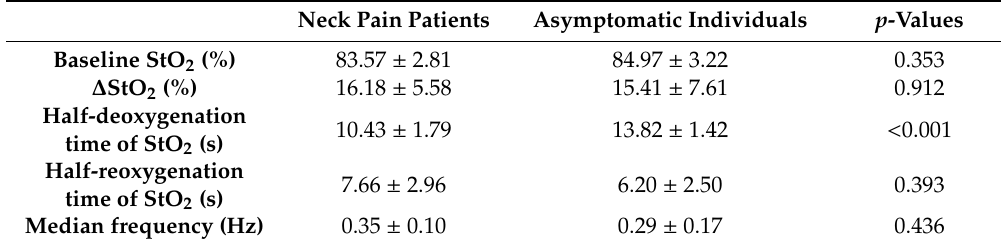
Figure 3. Representative time course of the oxygen saturation kinetics for the sternocleidomastoid muscle from one patient with nonspecific neck pain and an asymptomatic individual. ∆ StO 2 (%) was estimated from the maximum and minimum values of oxygen saturation while performing the requested task. Table 2. Muscular oxygenation variables of interest for nonspecific neck pain and asymptomatic groups.